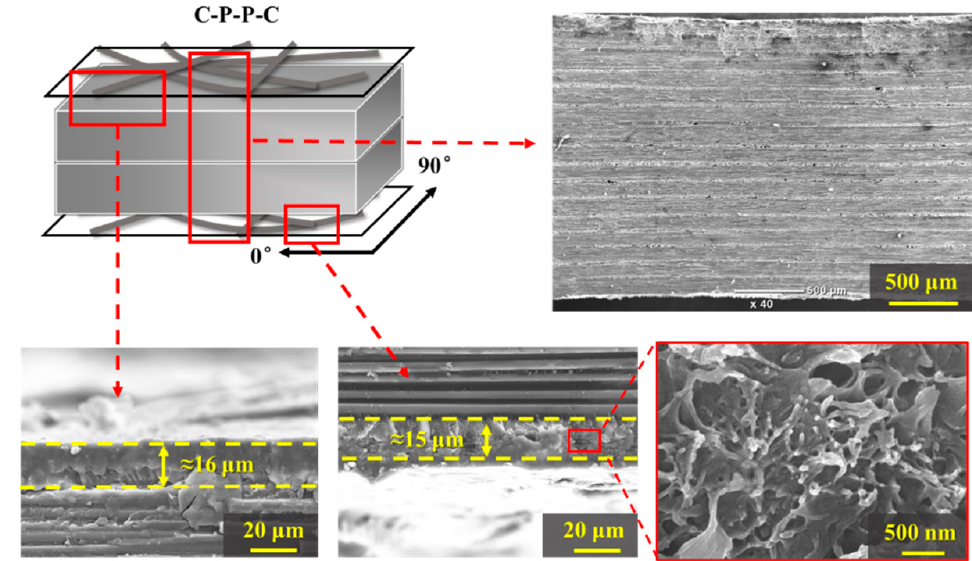
Figure 4. Microstructure of the composites with a special stacking sequence.